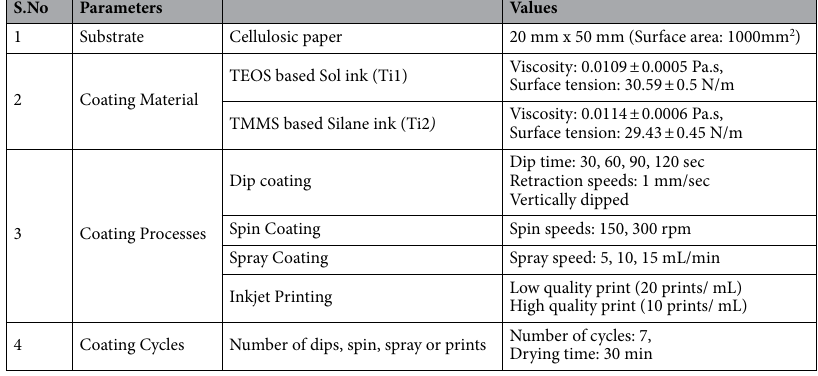
Table 1. Coating experiment process parametric and